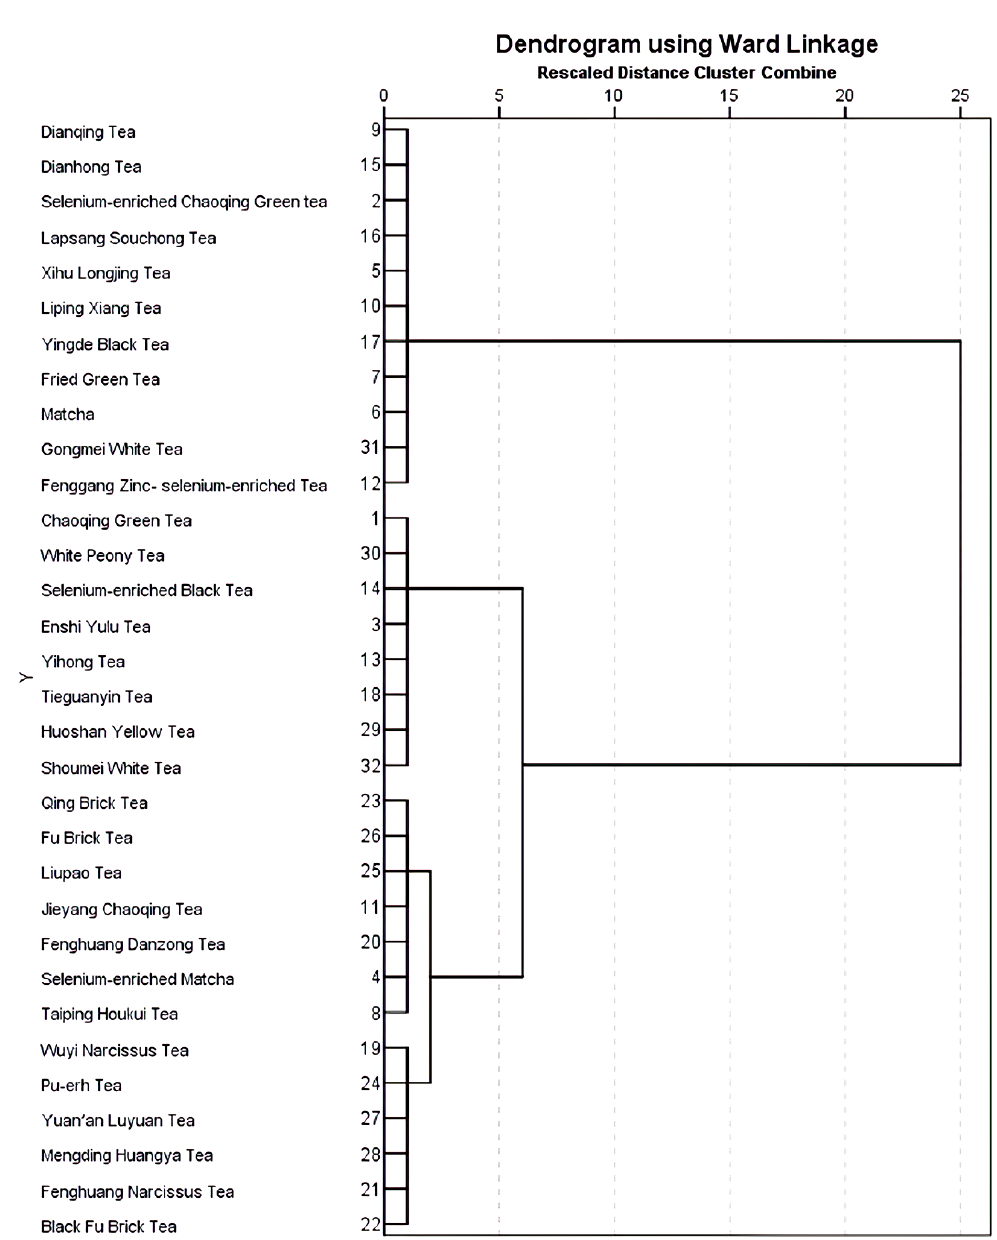
Figure 6. Dendrogram using Ward linkage from the systematic cluster analysis of 32 Chinese teas.